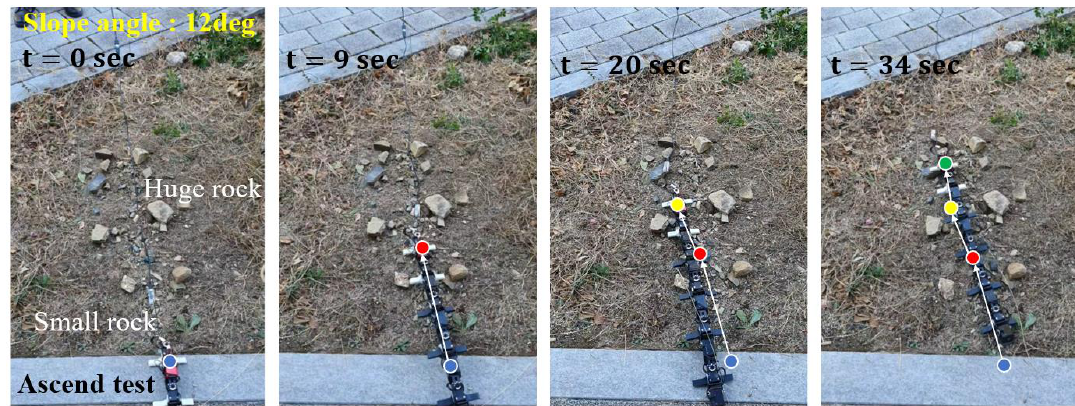
Figure 22. Performance of the ascending motion with the DAM on the rocks.